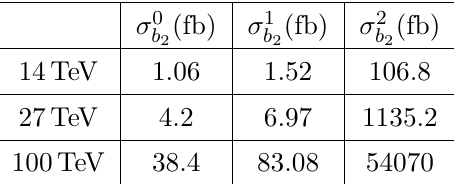
Table 13 . Coefficients σ 0 collider energies.